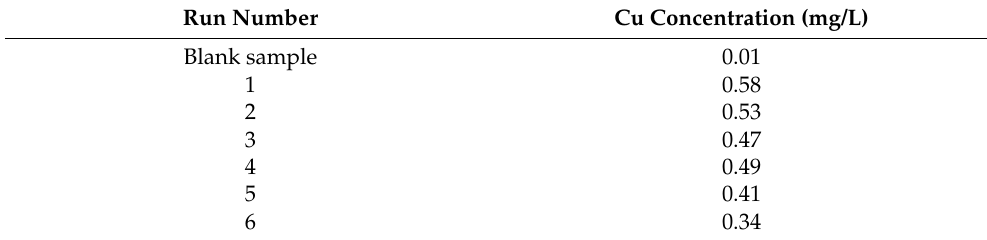
Figure 4. Effect of ( a ) various processes and ( b ) radicals’ scavengers on PDS activation for RhB degrada- tion. ( c ) Reusability of CU-THAp during PDS activation for RhB degradation in six consecutive cycles. (Operational conditions: (Cu–THAp) 0 = 1 g/L, (RhB) 0 = 20 mg/L, PDS = 7.5 mmol/L, and pH = 3). Table 2. Cu leaching to the aqueous solution.